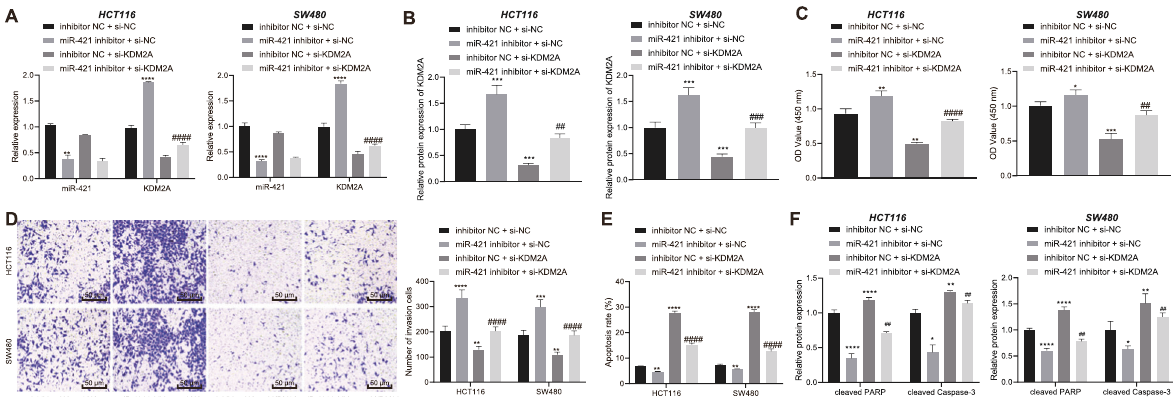
Fig. 4 Knockdown of miR-421 enhances the expression of KDM2A to facilitate the growth and invasion of CRC cells and inhibit their apoptosis. HCT116 and SW480 cells were transfected with miR-421 inhibitor, si-KDM2A or both. A Determination of miR-421 and KDM2A expression in HCT116 and SW480 cells by RT-qPCR. B Western blot assay for KDM2A protein level in HCT116 and SW480 cells. C – E CCK-8 assay, Transwell assay (200×) and fl ow cytometry for HCT116 and SW480 cell viability ( C ) invasion ( D ), and apoptosis ( E ). F Western blot assay of cleaved PARP and cleaved Caspase-3 proteins in HCT116 and SW480 cells. * p < 0.05, ** p < 0.01, *** p < 0.001, and **** p < 0.0001 compared with HCT116 cells transfected with inhibitor NC + si-NC. ## p < 0.01, and #### p < 0.0001, compared with HCT116 cells transfected with miR-421 inhibitor + si-NC. The measurement data are expressed as mean ± standard deviation. The experiments were repeated three times independently. Multi-group comparison was conducted by one-way ANOVA with Tukey ’ s post hoc